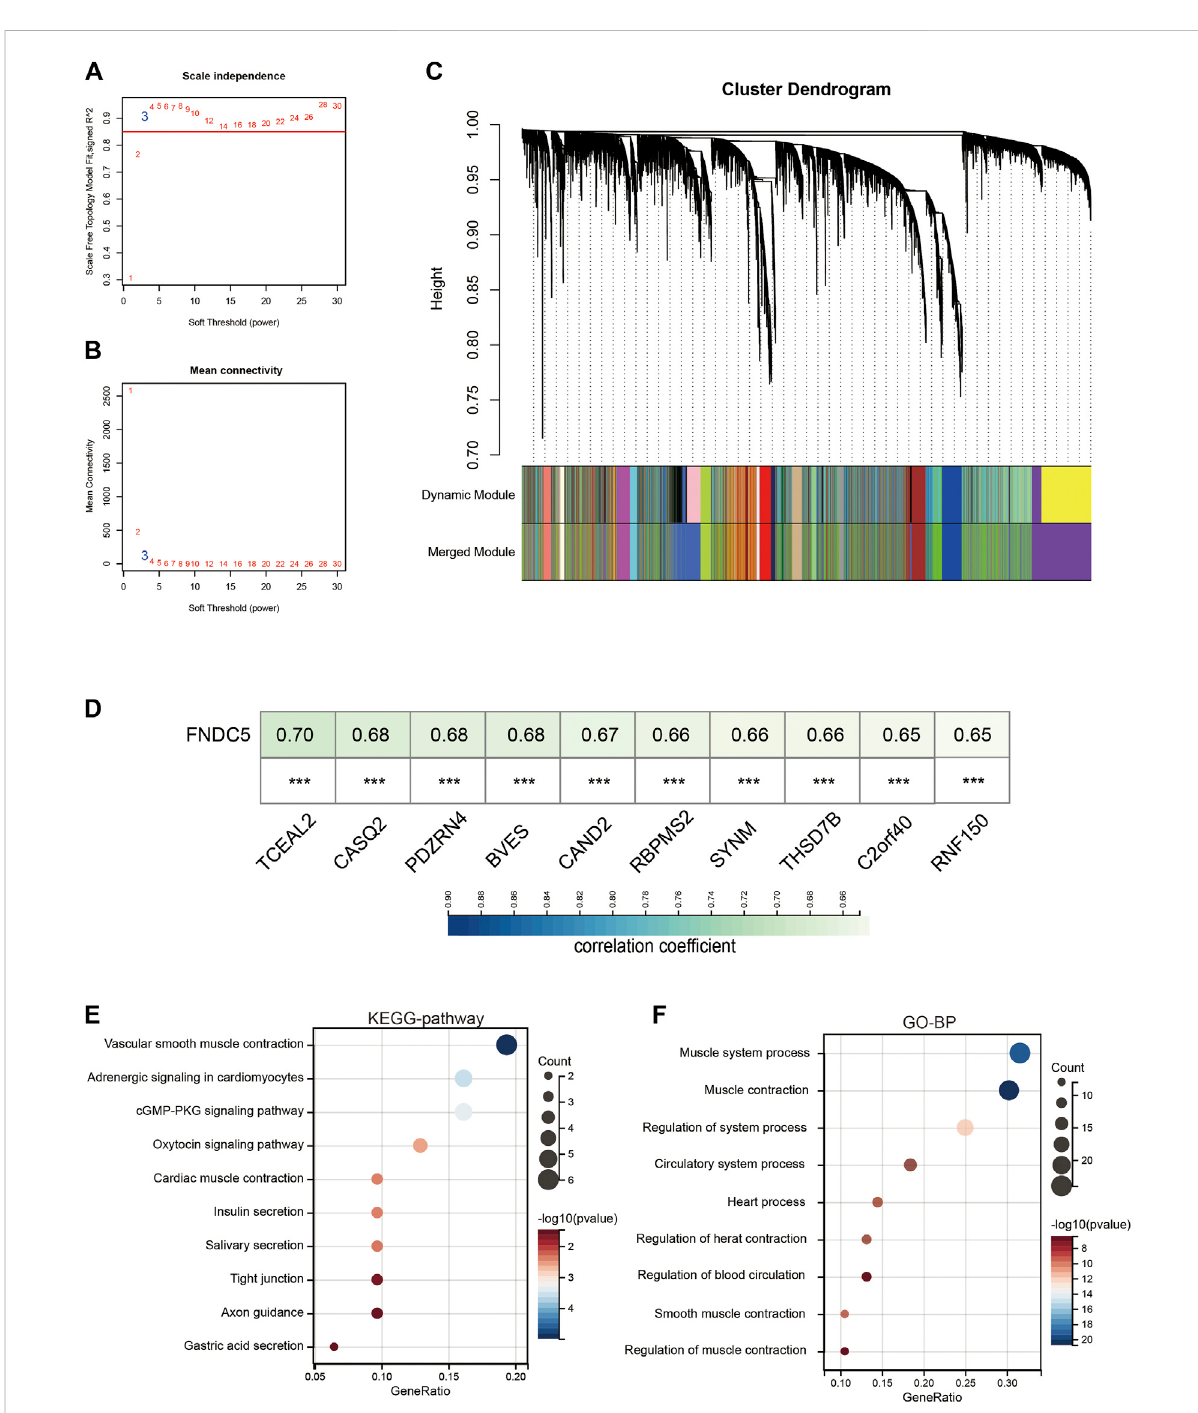
FIGURE 7 Co-expression module genes associated with FNDC5 were identi fi ed using WGCNA. (A) Relationship between scale-free topological model fi t and soft threshold (power) in the GSE62254 database. (B) Relationship between average connectivity and various soft thresholds in